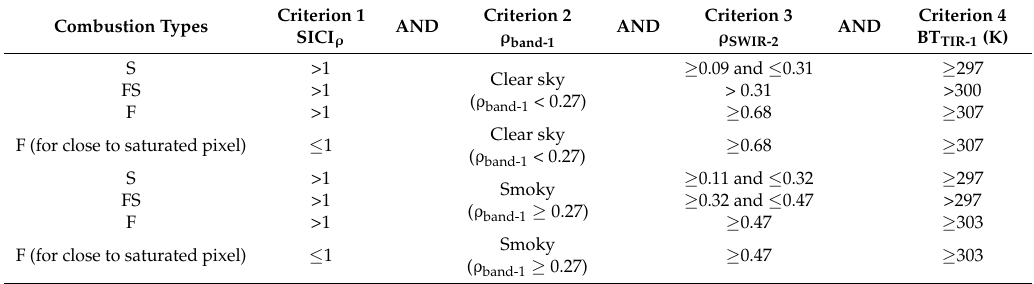
Table 3. The ToPeCAl for smouldering (S), mixture of flaming and smouldering (FS), and flaming (F) detection over clear sky conditions and smoky conditions. The criterion of SICI ρ must be satisfied together with the threshold values for SWIR-2 reflectance and TIR-1 brightness temperature (BT) of Landsat-8 data.